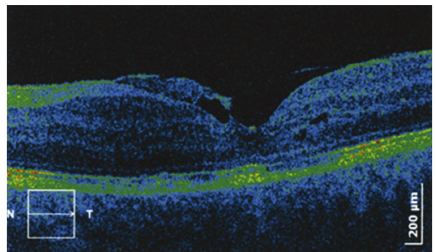
Figure 2: Behcet’s disease, macular edema with epiretinal mem- brane—OCT finding.